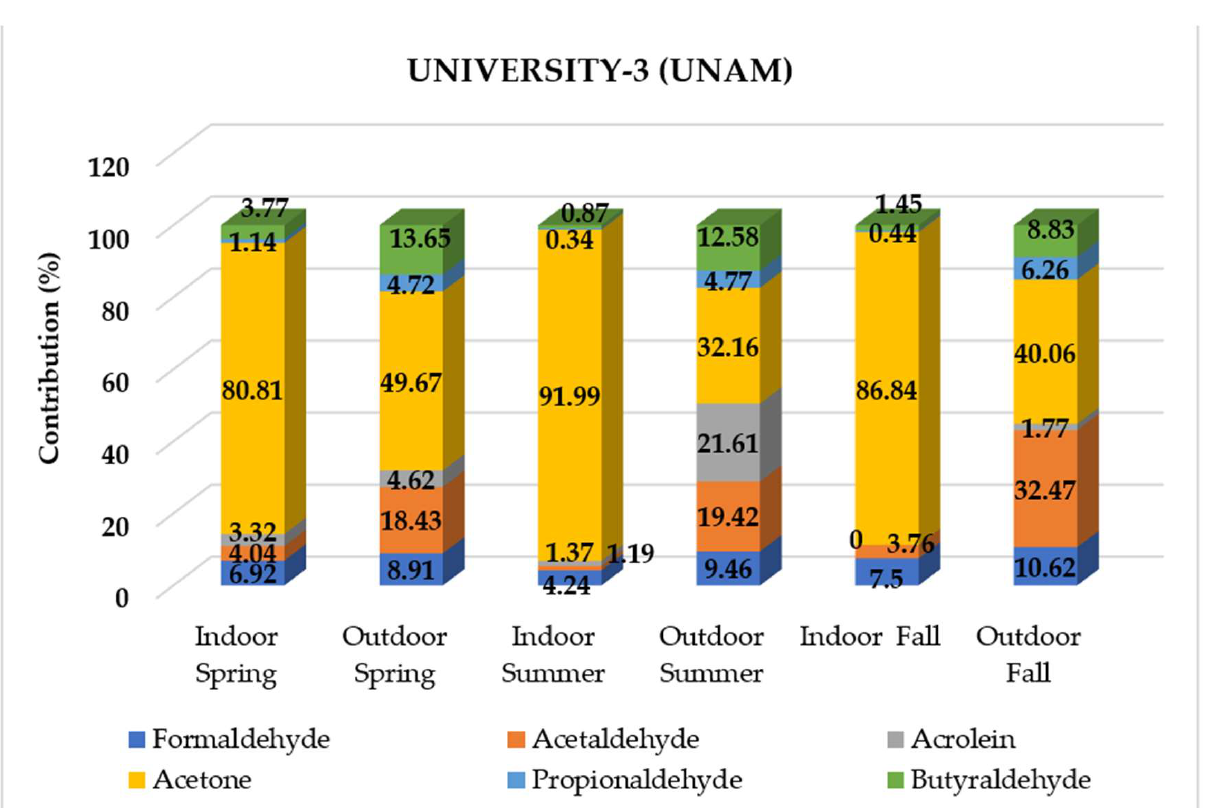
Figure 4. Seasonal variation of the contribution percentage of each carbonyl compound to the total carbonyl concentrations (indoor and outdoor) in University-3 (UNAM).